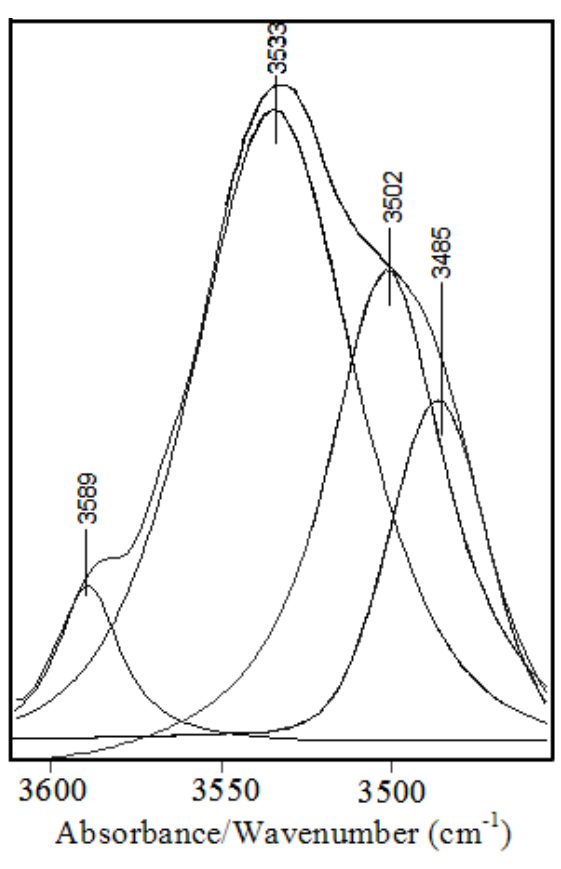
Fig. 6 3650 – 3400 cm − 1 curve-fitted IR-spectrum of 3 in acetonitrile